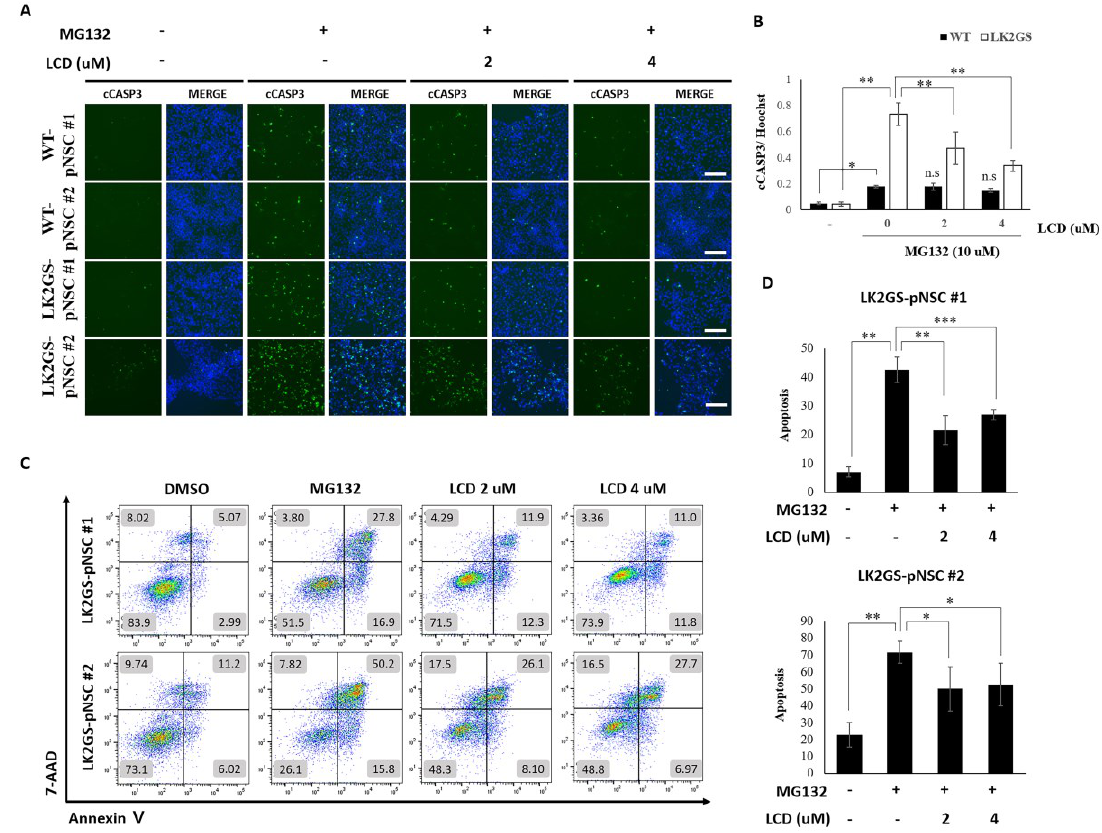
Figure 4. Effects of LCD on MG132-induced apoptosis in WT- and LK2GS-pNSCs. ( A ) Immunos- taining of cCASP3 was used to evaluate MG132-induced apoptosis and recovery by LCD treatment. Scale bars are 125 µ m. ( B ) Quantification of cCASP3 staining area after normalization using Hoechst staining area. p -values were analyzed using the unpaired two-tailed Student’s t -test (* p < 0.05, ** p < 0.01). ( C ) Flow cytometric analysis by Annexin V on the x -axis and 7-aminoactinomycin D concentration on the y -axis, following double staining of WT- and LK2GS-pNSCs treated with MG132 after LCD. ( D ) Quantitative data showing the percentage of apoptotic cells according to treatment (* p < 0.05, ** p < 0.01, *** p <